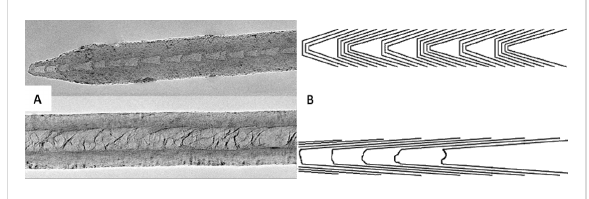
Figure 6: ( A ) TEM micrograph comparing two distinguishable types of nanotube morphologies: top – ‘bamboo’-like ( Synthesis VII ) and bottom – ‘membrane’-like ( Synthesis VIII ); and ( B ) graphical represen- tations thereof.